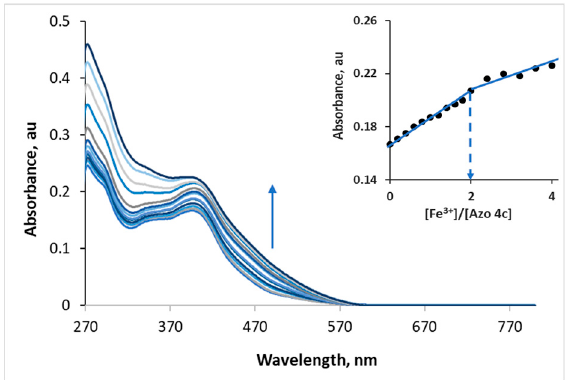
Figure 6. UV/vis titration of azo 4c (2.5 × 10 − 5 M) with Fe 3+ (1.5 × 10 − 3 M) in DMF. Inset: Molar ratio Figure 6. UV / vis titration of azo 4c (2.5 × 10 − 5 M) with Fe 3 + (1.5 × 10 − 3 M) in DMF. Inset: Molar ratio method for determination of the binding stoichiometry of azo 4c with Fe 3+ (4 equiv.). method for determination of the binding stoichiometry of azo 4c with Fe 3 + (4